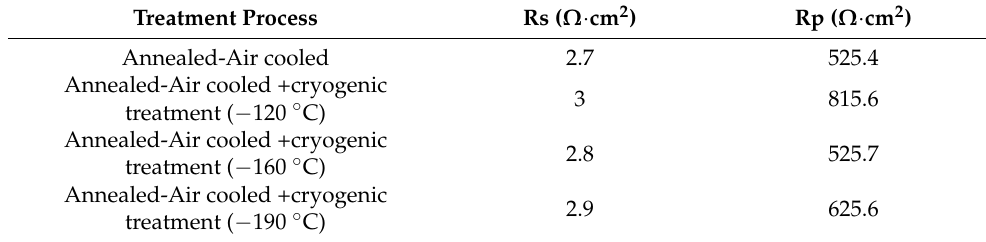
Table 4. EIS test fitting data.